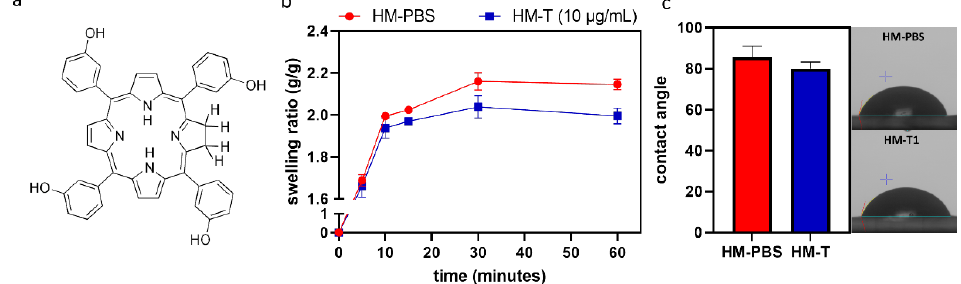
Figure 1. ( a ) Chemical structure of temoporfin (T). ( b ) Measurements of the swelling ratio of hydrogel membranes in terms of their weight rate for 1 h of immersion ( n = 3). ( c ) Contact angle, n = 5. ( b , c ) Mann – Whitney test.